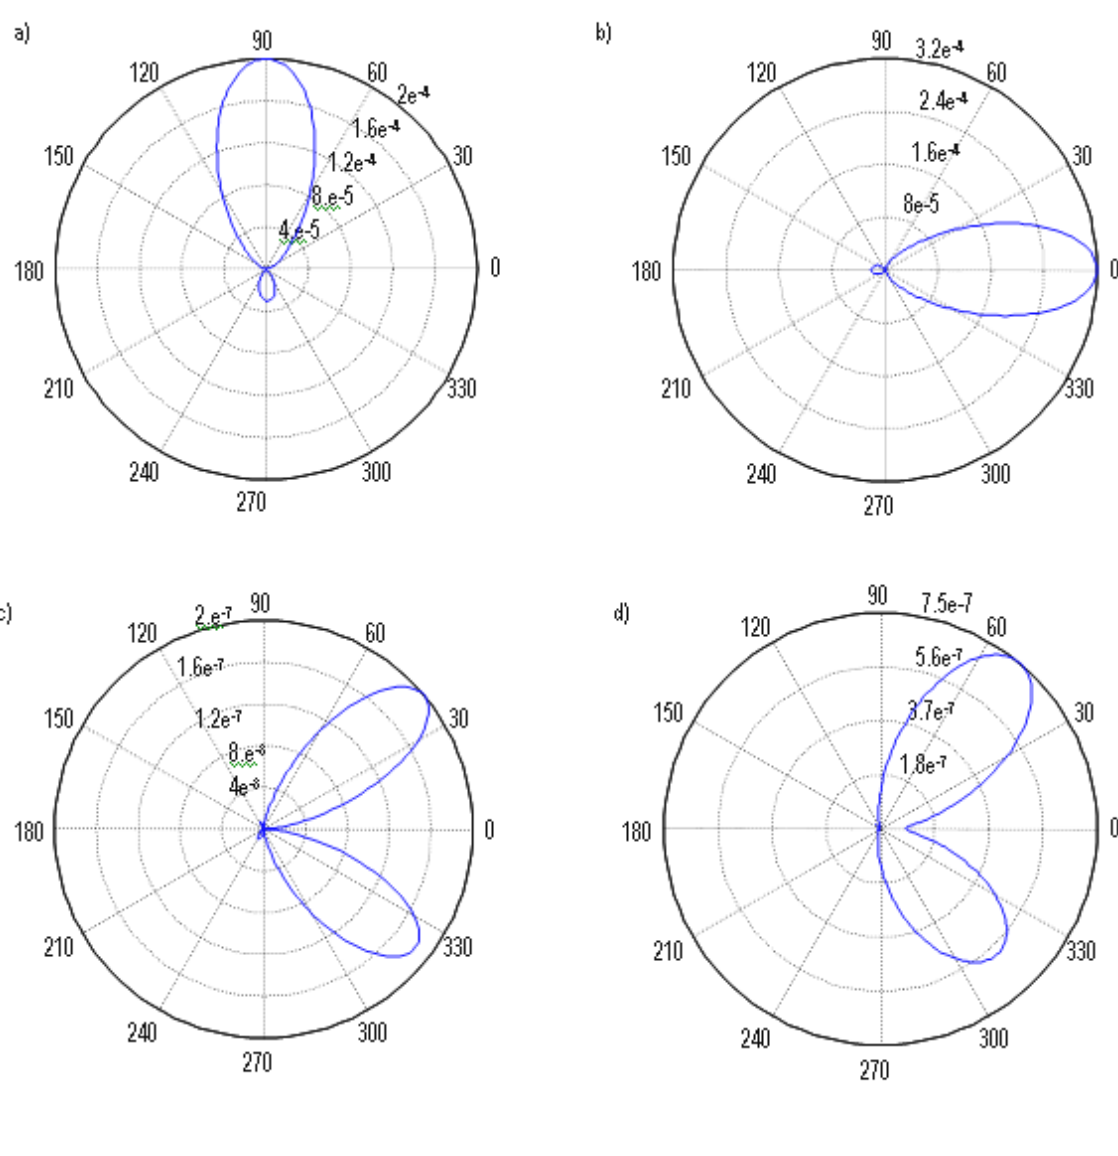
Figure 4. Bistatic scattering power patterns in the XY plane of a Pruppacher-Pitter raindrop: Equivolumetric radius 3.0 mm, frequency 34.8 GHz. Polarizations of the incident and scattered waves are (a) vertical-vertical, (b) horizontal-horizontal, (c) vertical- horizontal, (d)